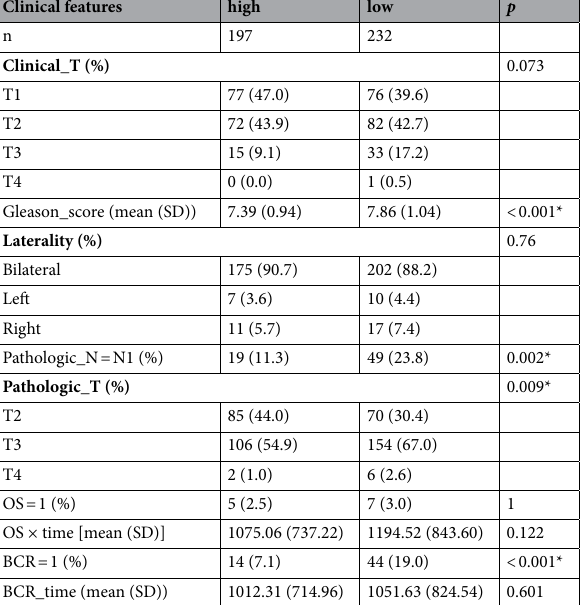
Table 1. Differences in clinical phenotypes after grouping. *Statistically significant (α = 0.05). SD Standard Deviation, N Node, T Tumor, OS Overall Surviva, BCR Biochemical